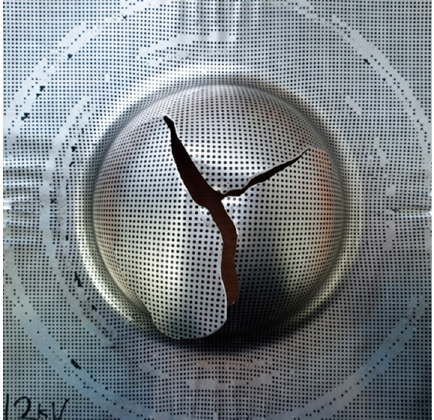
Figure 15. Experimental results from EHF experiment at 12 kV.